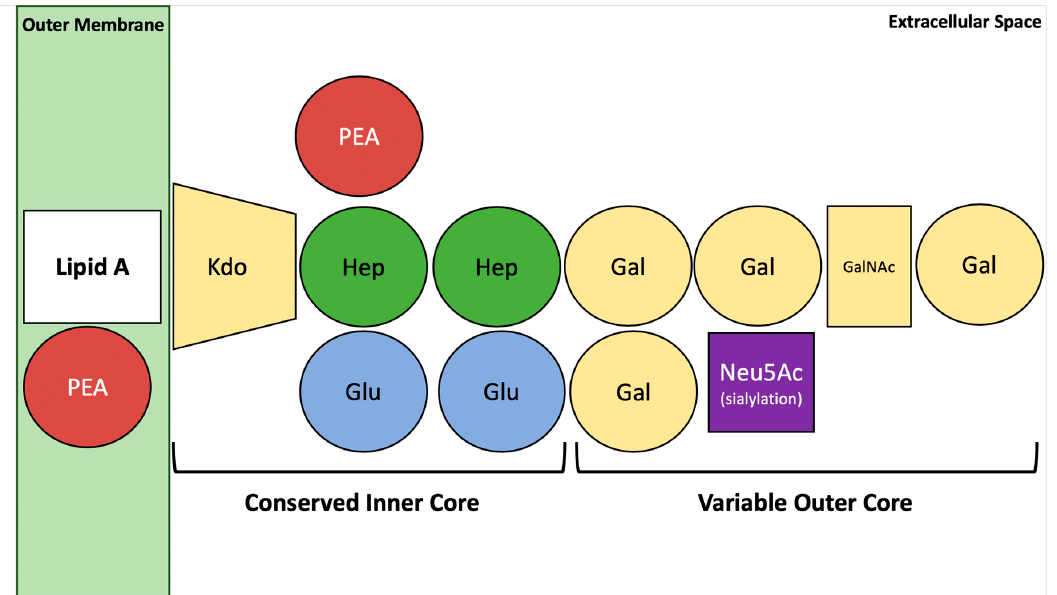
Figure 2. The basal structure of C. jejuni LOS. The LOS of C. jejuni consists of Lipid A, Figure2. Thebasalstructureof C.jejuni LOS.TheLOSof C.jejuni consistsofLipidA,phostoethanolamine phostoethanolamine (PEA), 3-Deoxy-d-manno-oct-2-ulosonic acid or keto-deoxyoctulosonate (Kdo), (PEA), 3-Deoxy-d-manno-oct-2-ulosonic acid or keto-deoxyoctulosonate (Kdo), Heptose (Hep), glucose Heptose (Hep), glucose (Glu), galactose (Gal), N-acetylgalactosamine (GalNAc), and N- (Glu), galactose (Gal), N-acetylgalactosamine (GalNAc), and N-acetylneuraminic acid (Neu5Ac) and in acetylneuraminic acid (Neu5Ac) and in sialylated form mimics a range of gangliosides (e.g., GM1). sialylated form mimics a range of gangliosides (e.g., GM1). The characteristic O-antigen of LPS from The characteristic O-antigen of LPS from Gram-negative bacteria is missing. Gram-negative bacteria is